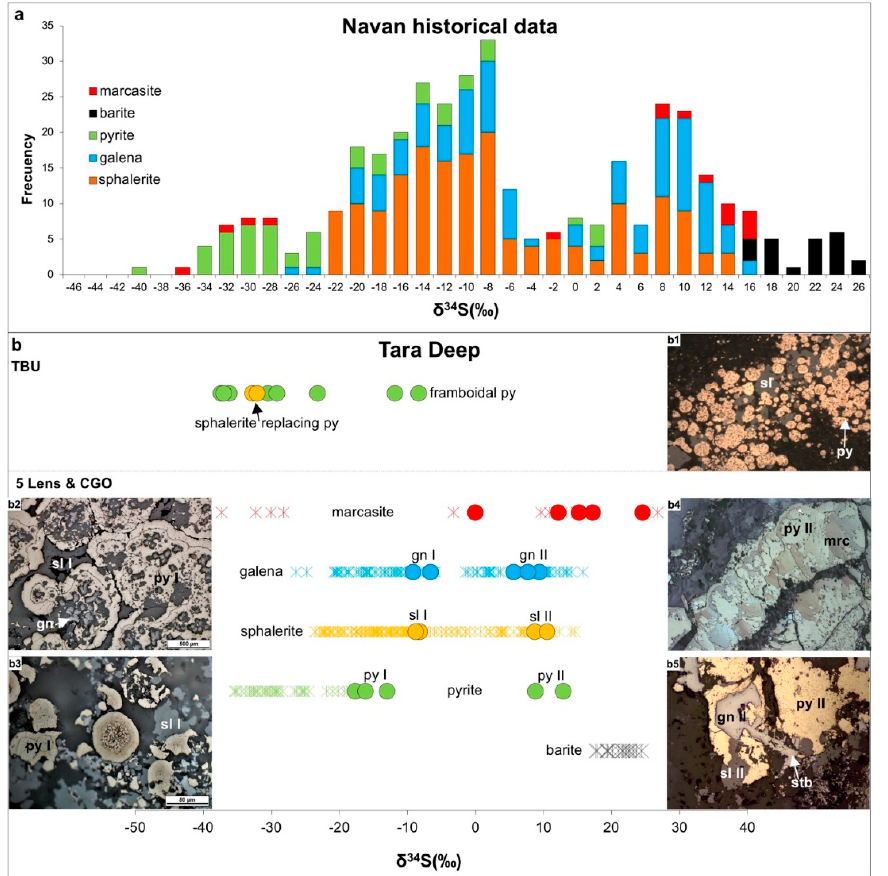
Figure 7. S isotope analyses from the Navan system. ( a ) Histogram showing published S isotope data